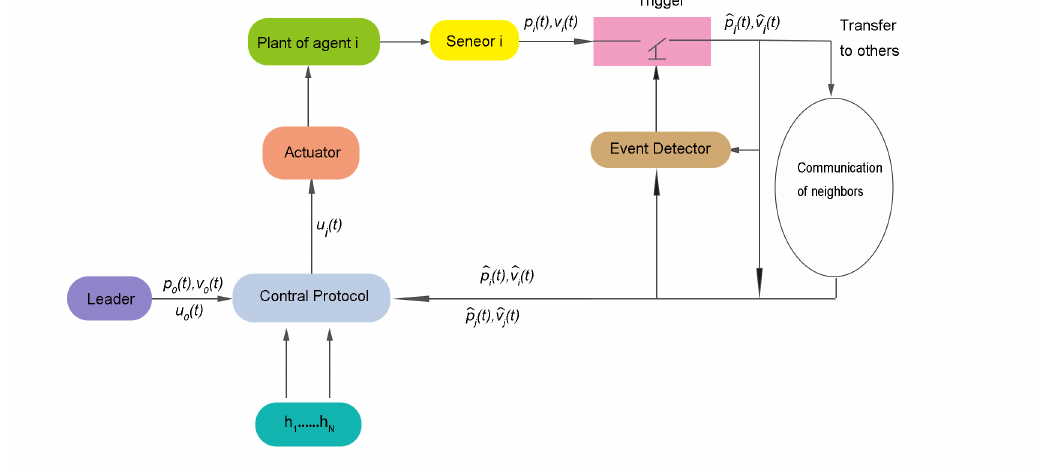
Figure 1. Schematic of